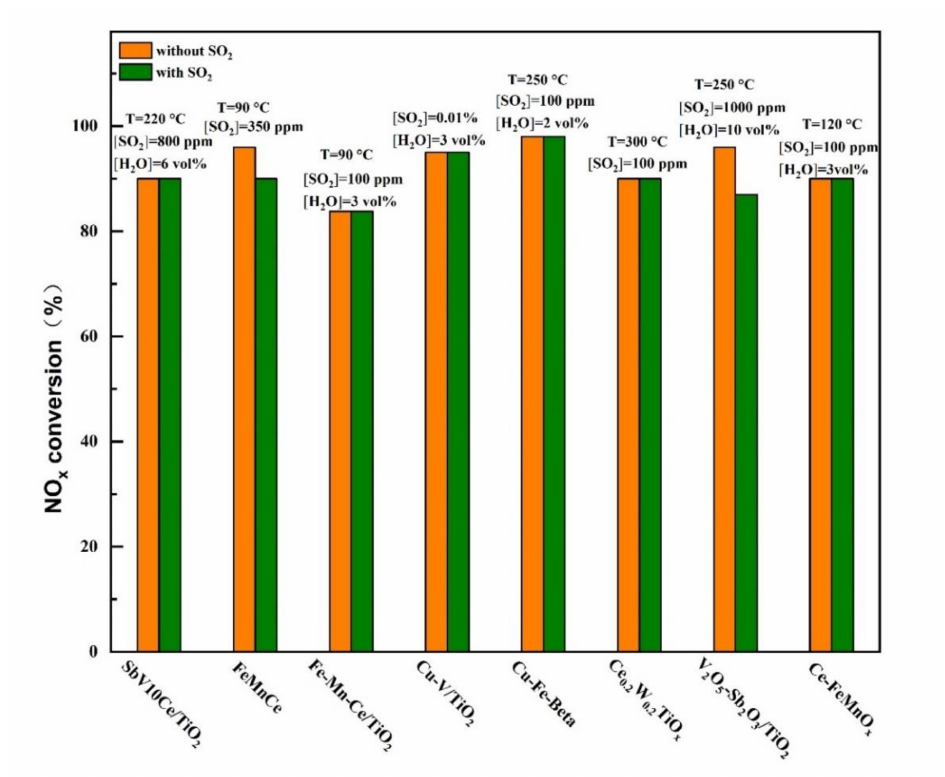
Figure 10. Typical SO 2 -tolerant modified catalyst at low temperatures for selective catalytic reduction (SCR) reaction